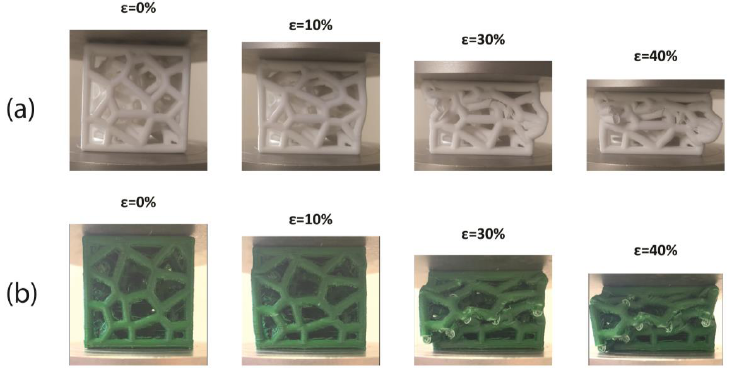
Figure 13. The compression stages of the Voronoi structures illustrated for: ( a ) neat PLA; ( b ) PLA/PHA compound. Meshing was generated using a hexahedral for the top compression plate and tetrahedral elements for complex geometries. In Figure 14a, the finite element analysis (FEA) results of force-displacement behavior are demonstrated, revealing a good correlation between the experimental compression tests and the force-displacement data generated by FEA simulations for the 3D-printed specimens. It is worth mentioning that at larger displacements, the experimental curves start to deviate more from the FEA simulation because the 3D printing defects play a larger role in the bending response. The material model parameters were examined to minimize the difference between the simulated and the experimental force-displacement data. Therefore, the results of the deformation and the equivalent von Mises stress distribution on the 3D-printed Voronoi lattice structures under compressive load, as shown in Figure 14b,c, may accurately indicate the high-stress regions of the structures. Based on the mechanical test results, it can be established that the computationally generated (FEA) compression test data, assisted by the actual measurements could be an effective method to characterize the mechanical deformation behavior of 3D-printed Voronoi structures.